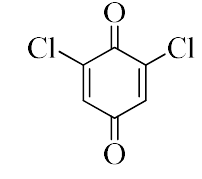
Figure 5. Disinfection by-products from EHMB chlorination.